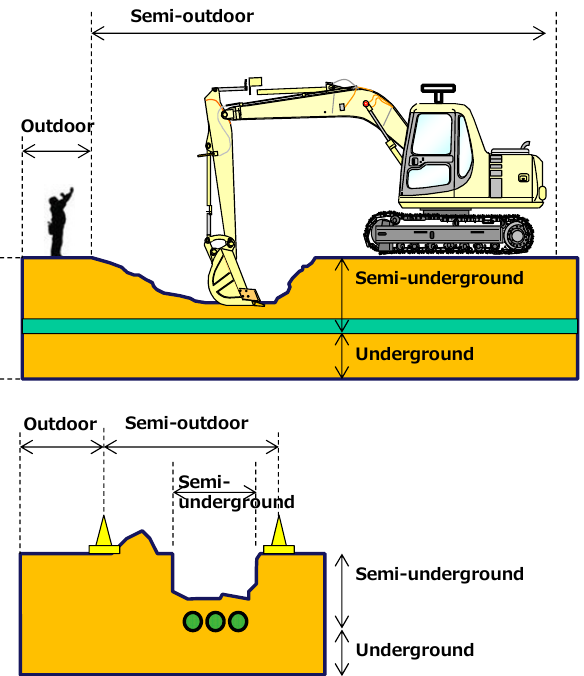
Figure 5. Subdivided construction space